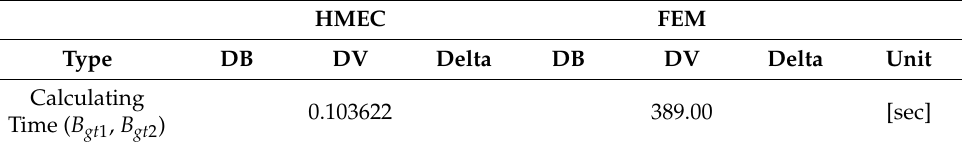
Table 4. Comparison of calculation time about air gap flux density